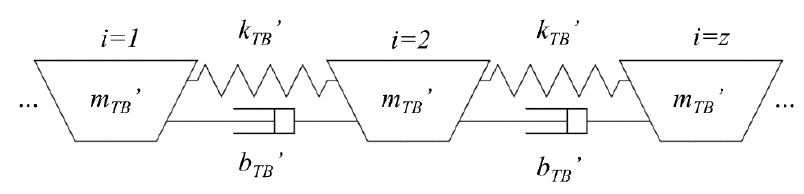
Figure 2. Model of the toothed belt within the drive system.